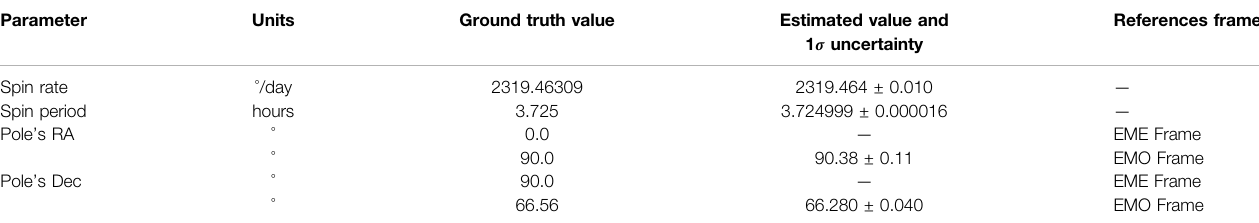
TABLE 4 | Comparing estimated body rotation parameters to the ground